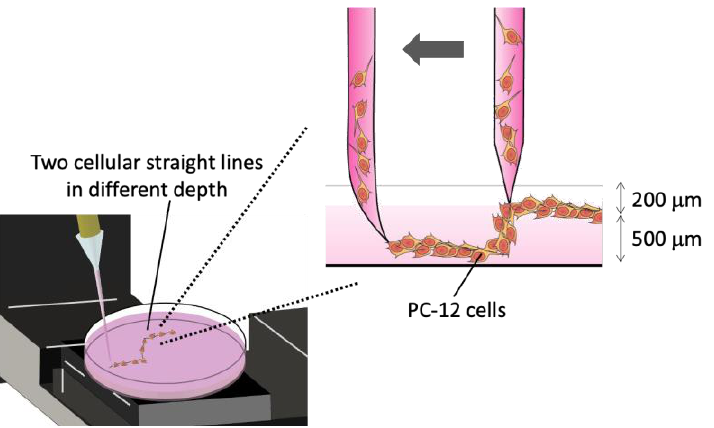
Figure 2. Schematic of micro-injection of PC-12 cells to draw two straight lines of cells with different depth in a collagen gel.